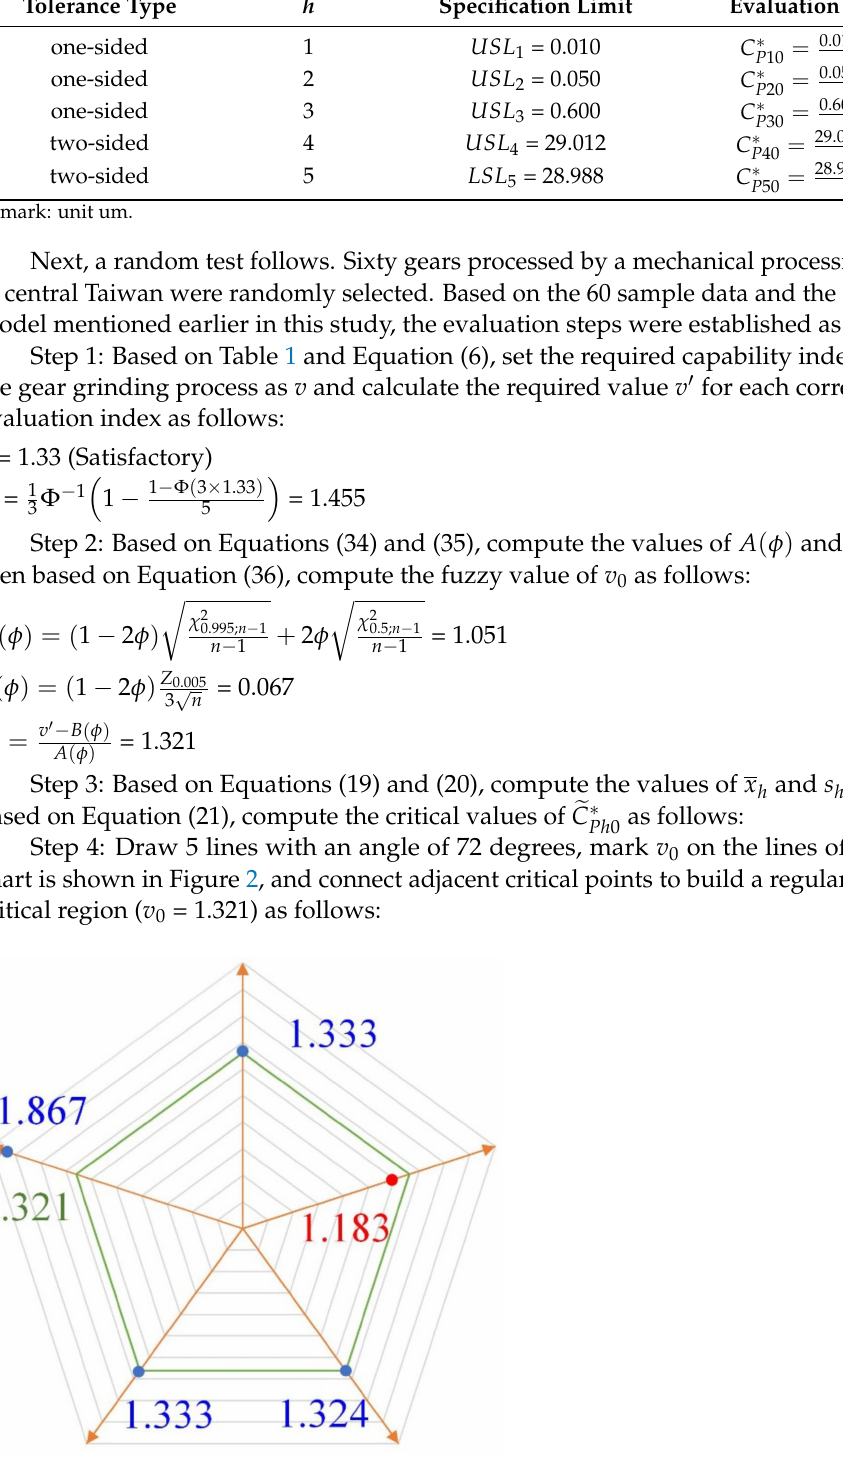
Figure 2. Critical region on a radar